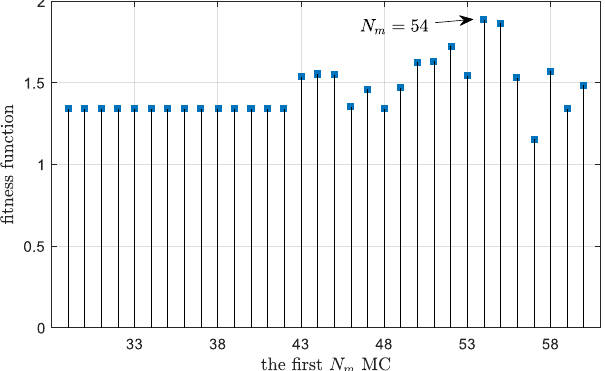
Figure 12. Fitness function of damage case C at a 3% level of noise, for the ITR method.